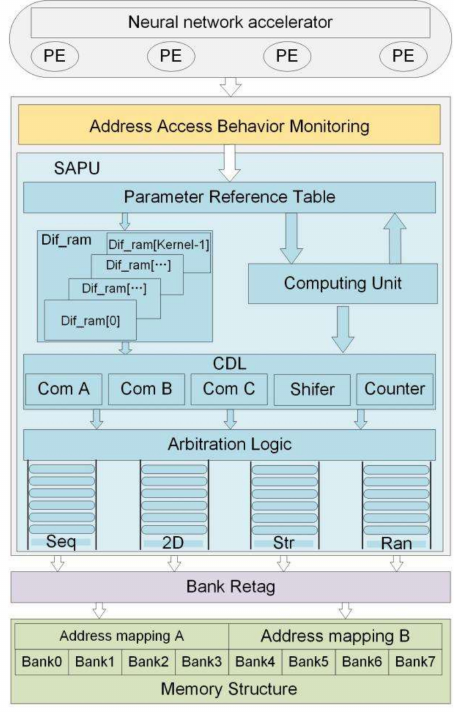
Figure 5. Basic structure of the proposed NNAMC.